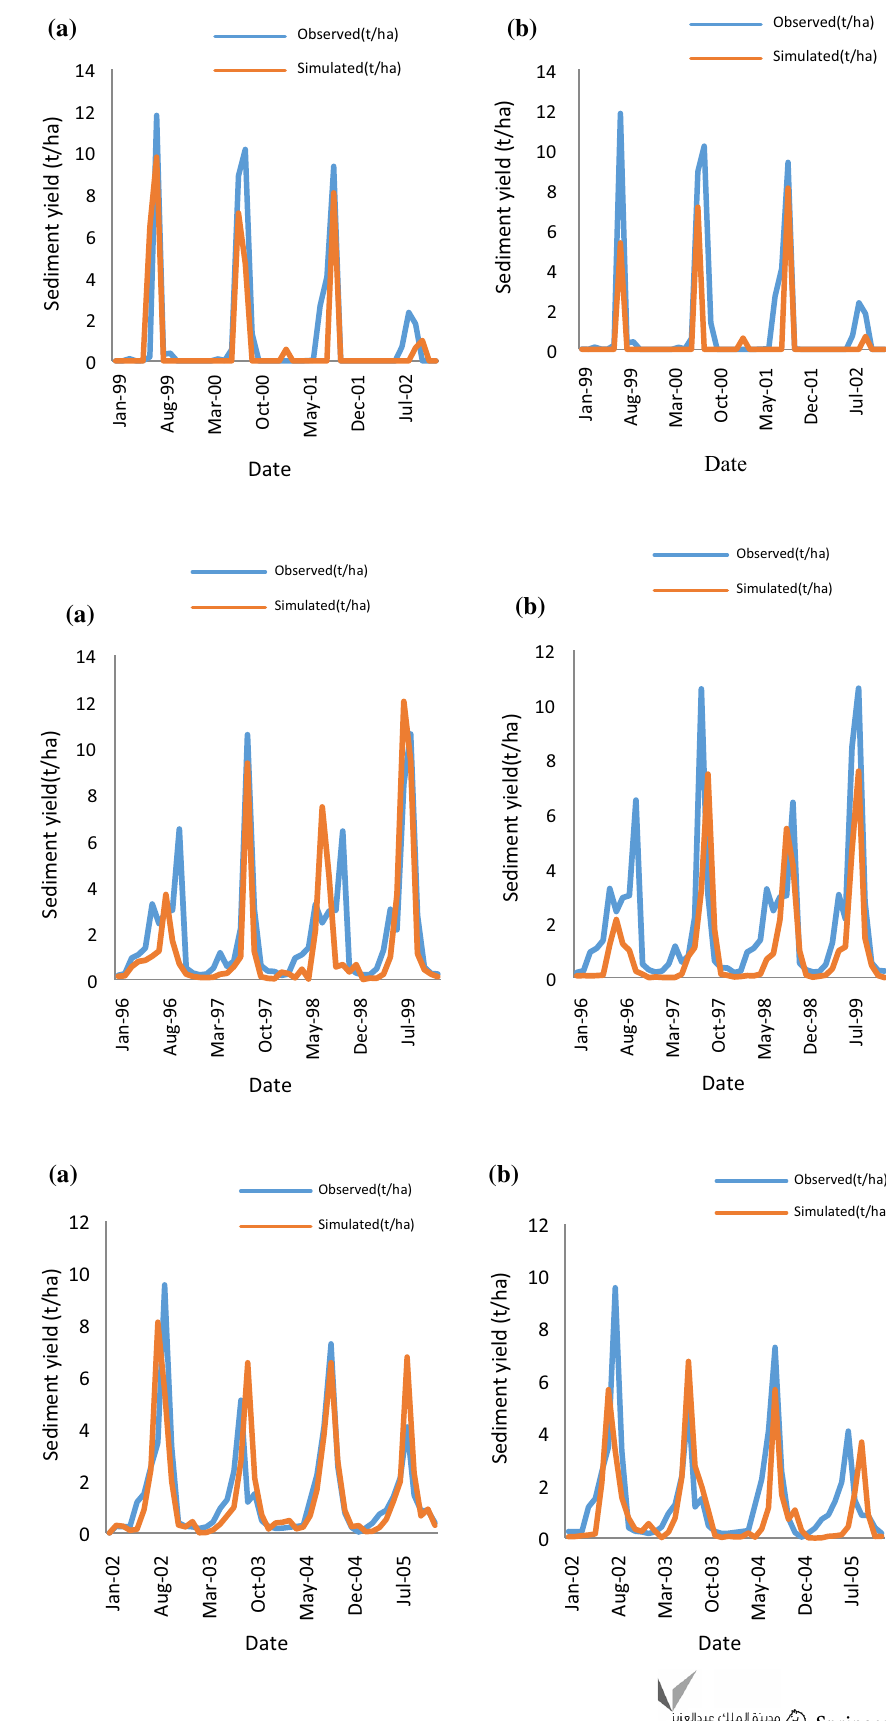
Fig. 16 Observed and simulated monthly sediment yield for model validation (1999–2002) of Pong dam for a ERA-Interim and b IMD weather data